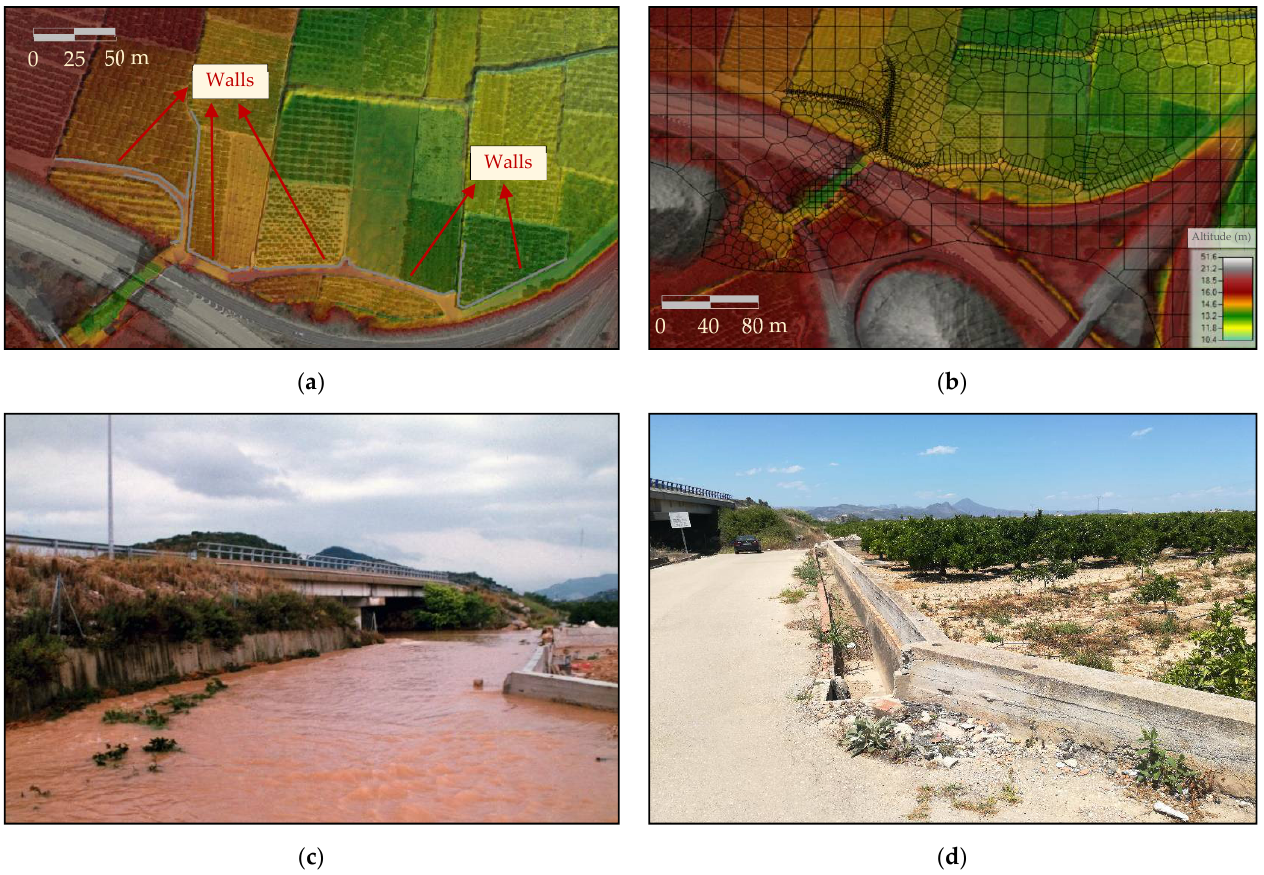
Figure 13. Example of modifications conducted in the hydraulic model for ensuring consistency: ( a ) detail of the opening of the transverse drainage below the highway and inclusion of agricultural plot walls in the surrounding area (breaklines in grey color); ( b ) mesh structure including the presence of the aforementioned elements; ( c ) image of the area in flooding situations; ( d ) image of the area in a dry situation.